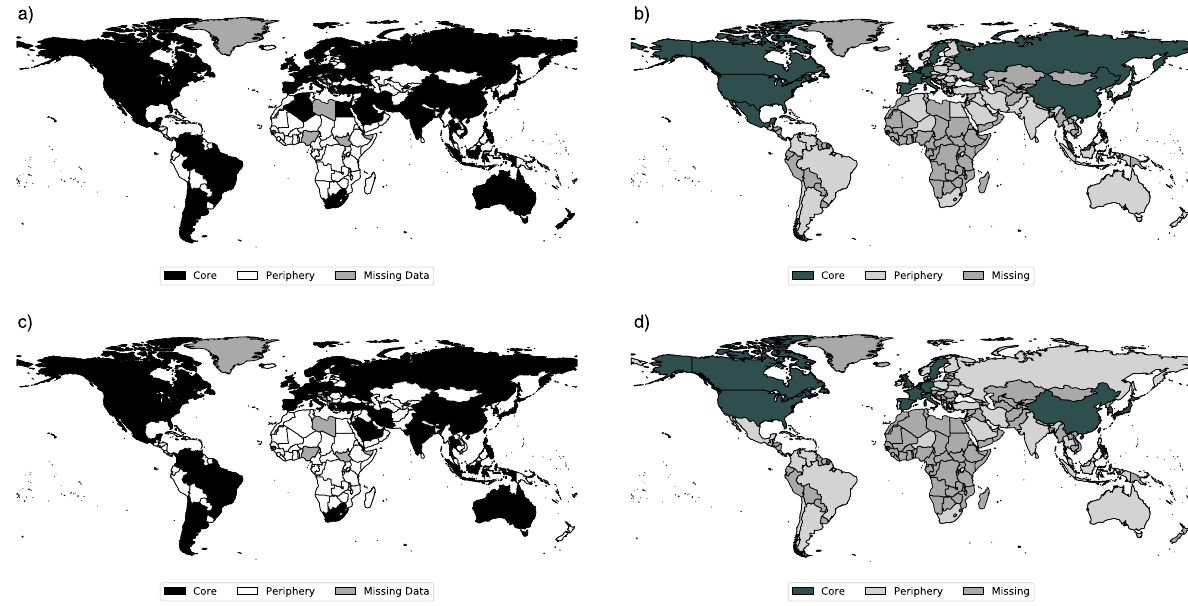
Fig. 10 Detection of nested bimodular structures. Result of the application of our framework for the detection of weighted bimodular structures on the world trade web (WTW) in the year 2000 36 . a , b upon running W == in a hierarchical fashion, a core-within-the-core is detected, revealing that the richest world countries (i.e. Canada, USA, the richest European countries, China and Russia — right panel, in dark green) constitute an even more tightly linked cluster of nations among the ones with the largest trading activity ( a ). c , d E == penalizes the countries with both a small degree and a small strength; in fact, the second run excludes the Russia, a result seemingly indicating that while its strength is ‘ large enough ’ to be a member of the core, its degree is not.